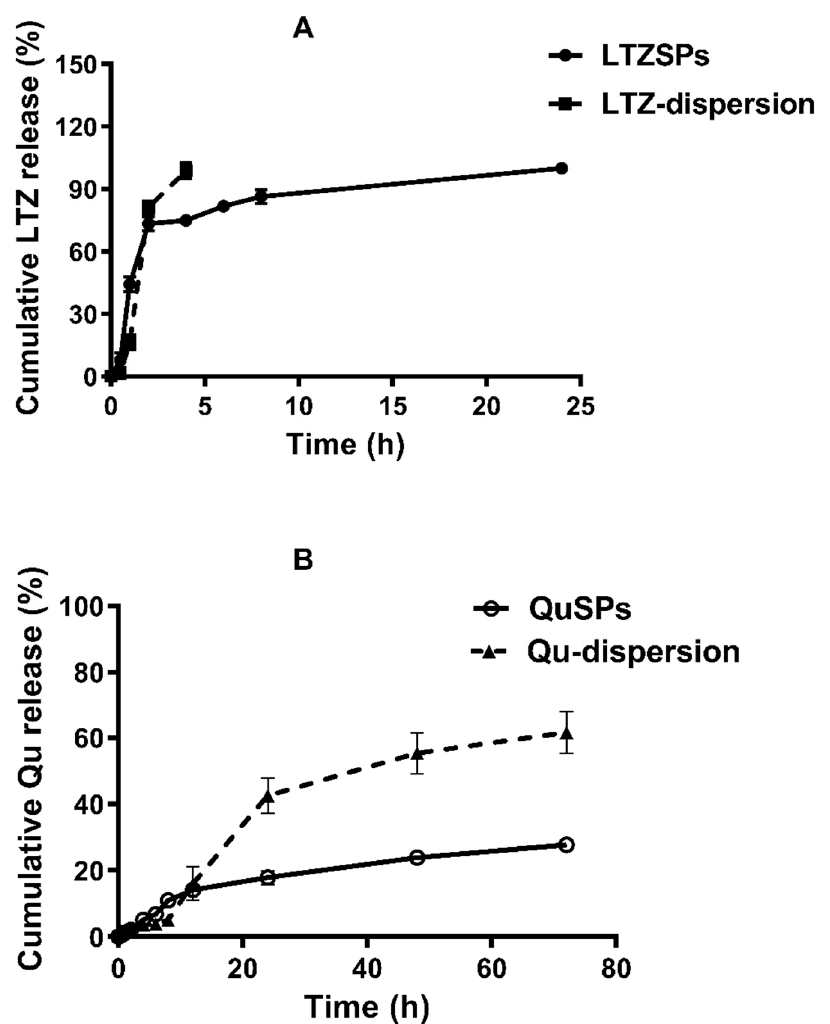
Figure 3. Cumulative in vitro release profiles of ( A ) The optimized LTZSPs compared to free LTZ dispersion in hydroalcoholic PBS solution pH 7.4 at 37 ◦ C. ( B ) The optimized QuSPs compared to free Qu dispersion in PBS pH 7.4 plus 1% Tween 80 at 37 ◦ C. Data are expressed as mean ± SD ( n = 3). Abbreviations: LTZ; letrozole, Qu; quercetin, LTZSPs; letrozole-loaded spanlastics,